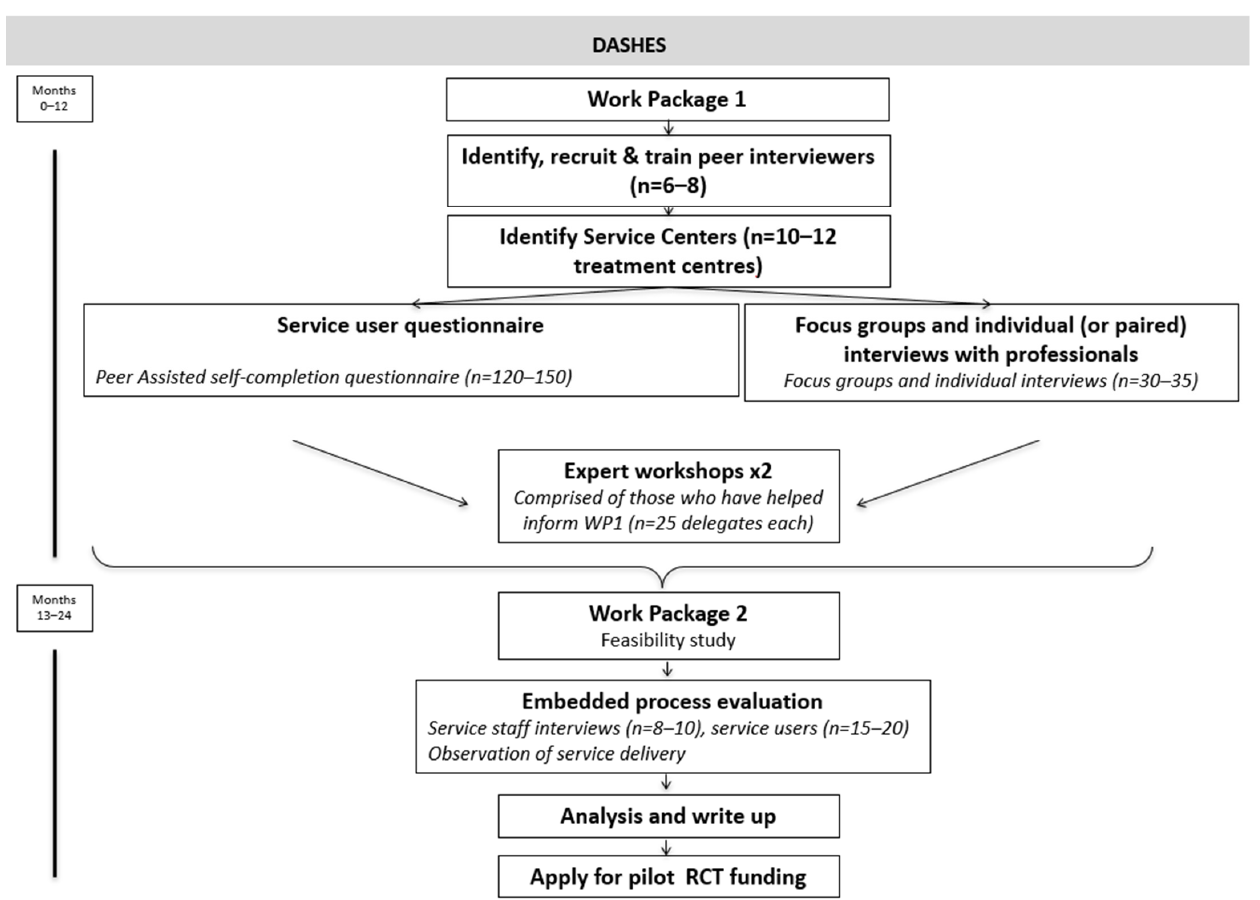
Figure 1. Overview of the study design.